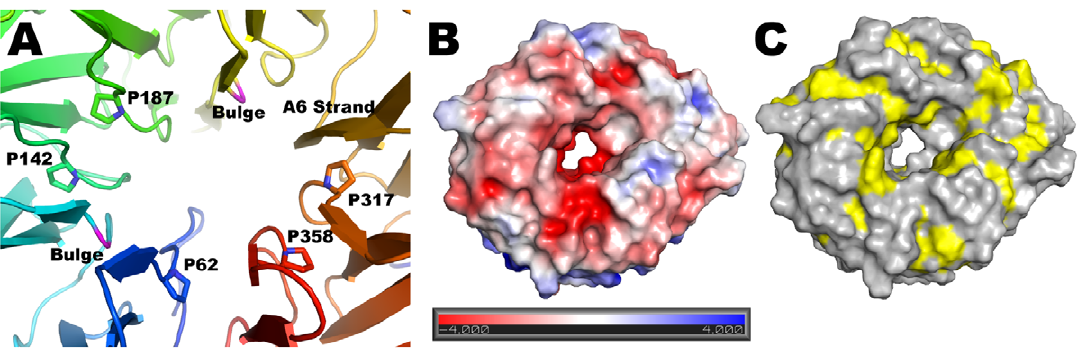
Figure 2. Central pore and surface characteristics of BamB. (A) Seven of the A strands lining the central pore are irregular due to conserved proline residues and two bulges (shown in magenta). The A6 strand has a regular b conformation along the entire pore (shown in orange). (B and C) Top view of a surface representation of BamB colored by electrostatic surface potential (B) or hydrophobicity (C) showing the central pore in the structure.